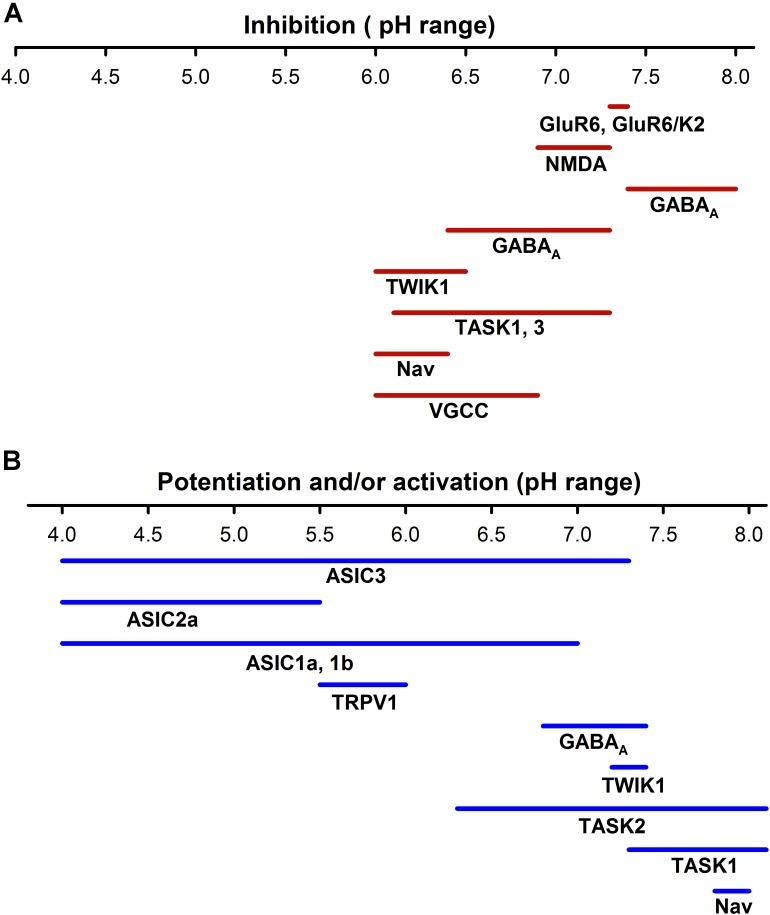
Sensitivity to pH of different neuronal ion channels. (A) Inhibition by pH of different neural ionic channels span from a pH of about 6.0 to 8.0, which indicates that at normal pH (7.4) a certain percentage of receptors such as KAR, AMPAR, or NMDAR are partially blocked. (B) ASICs are activated from a range of pHs from <7.8 to 4.0; in contrast the TRPV1 channels are much less sensitive to pH. Other channels such as voltage -gated K+, Na+, and Ca2+ channels can increase their activity at more alkaline pHs. The potentiation or activation of different channels has a much higher range (pH 4–8.0) than inhibition.